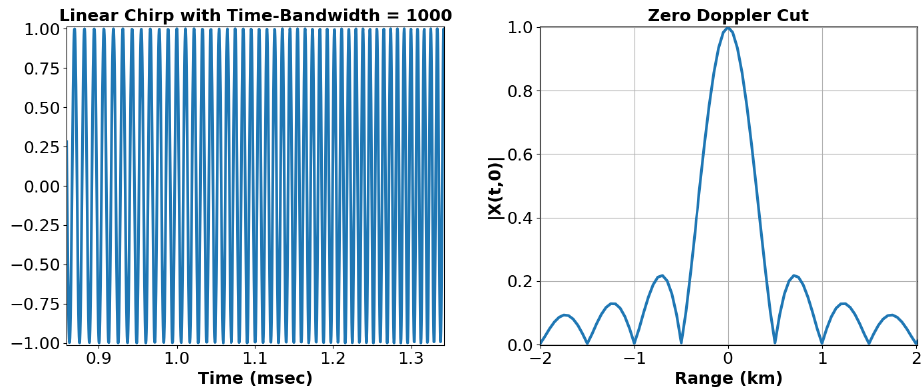
Figure 8. Part of the chirp waveform ( left ) and zero cut of AF ( right